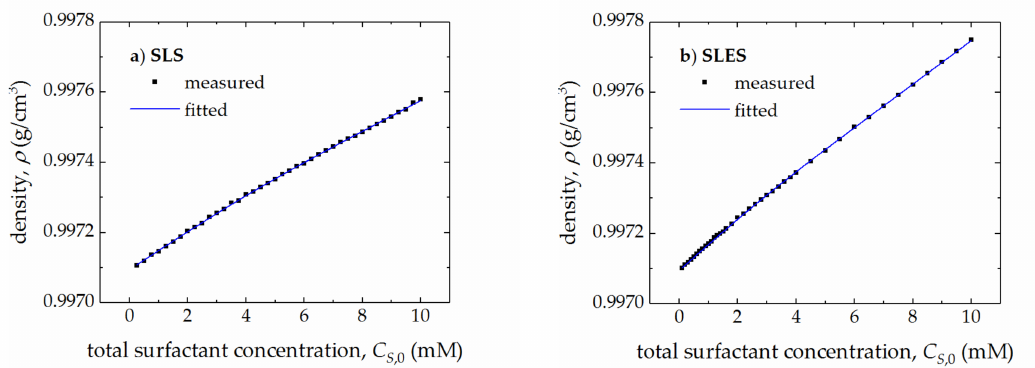
Figure 3. The measured and fitted values of density, ρ , of the aqueous solutions of SLS ( a ) and SLES ( b ) vs. the total surfactant concentration, C S ,0